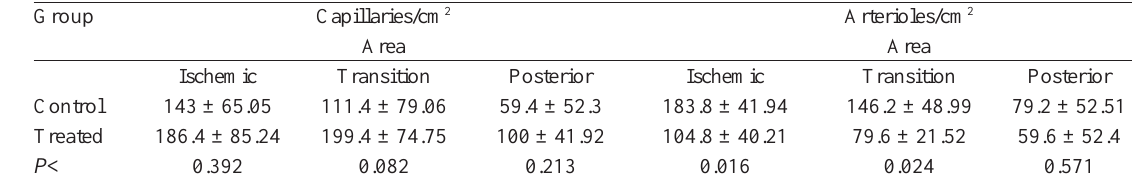
Table 1. Number of capillaries and arterioles per square centimeter in each of the three areas analyzed under histological examination. Capillaries were defined as vessels under 25mm and arterioles those between 25 and 100 mm in diameter. Areas: Ischemic was the center, where some fibrosis could be identified, Transition was between ischemic and normal myocardium, Posterior was the dorsal area of normal myocardium away from the